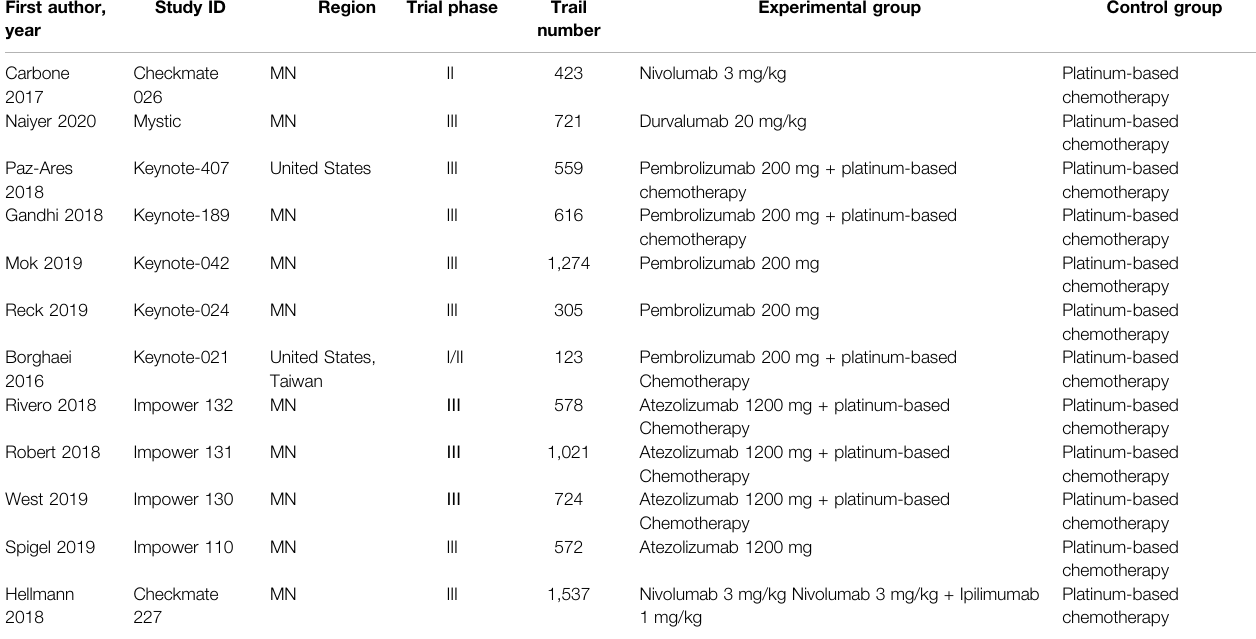
TABLE 1 | General characteristics of the included randomised control trials for this network meta-analyses (Abbreviations: MN,multinational; NA, not